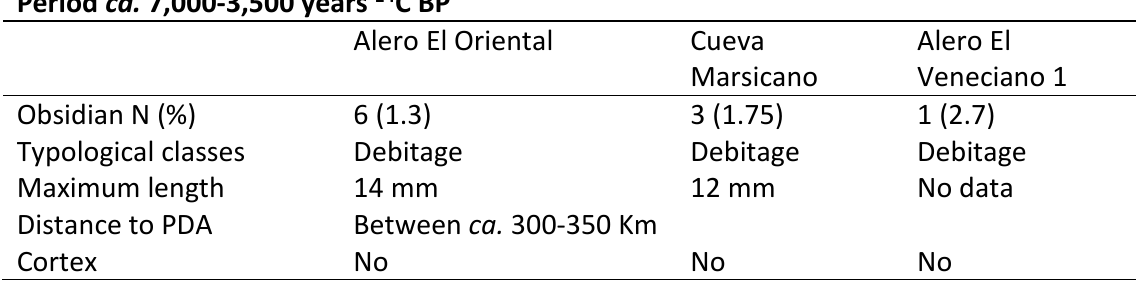
Table 2. Characteristics of obsidian assemblages of the period ca. 7,000-3,500 years 14 C BP.